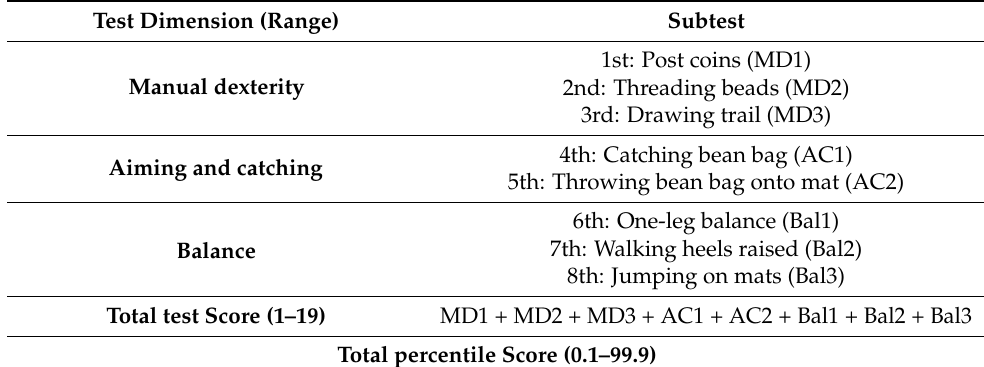
Table 1. MABC-2 test